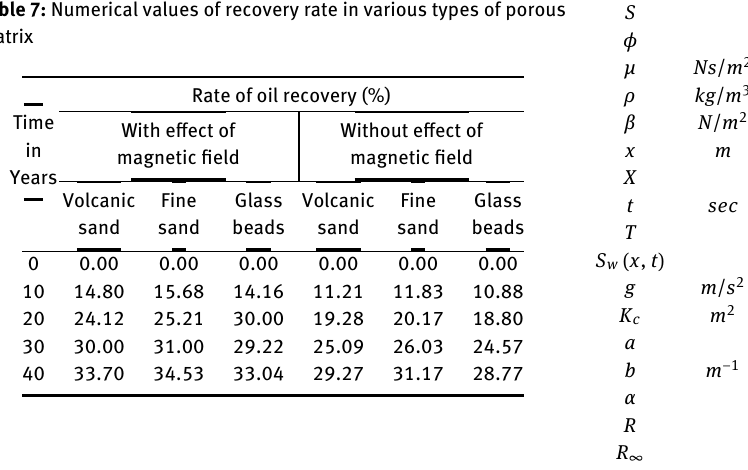
Table 7 and 8 discuss the numerical values of the re- covery rate in fractured and in matrix porous medium in different porous materials with and without considering the magnetic field effect.